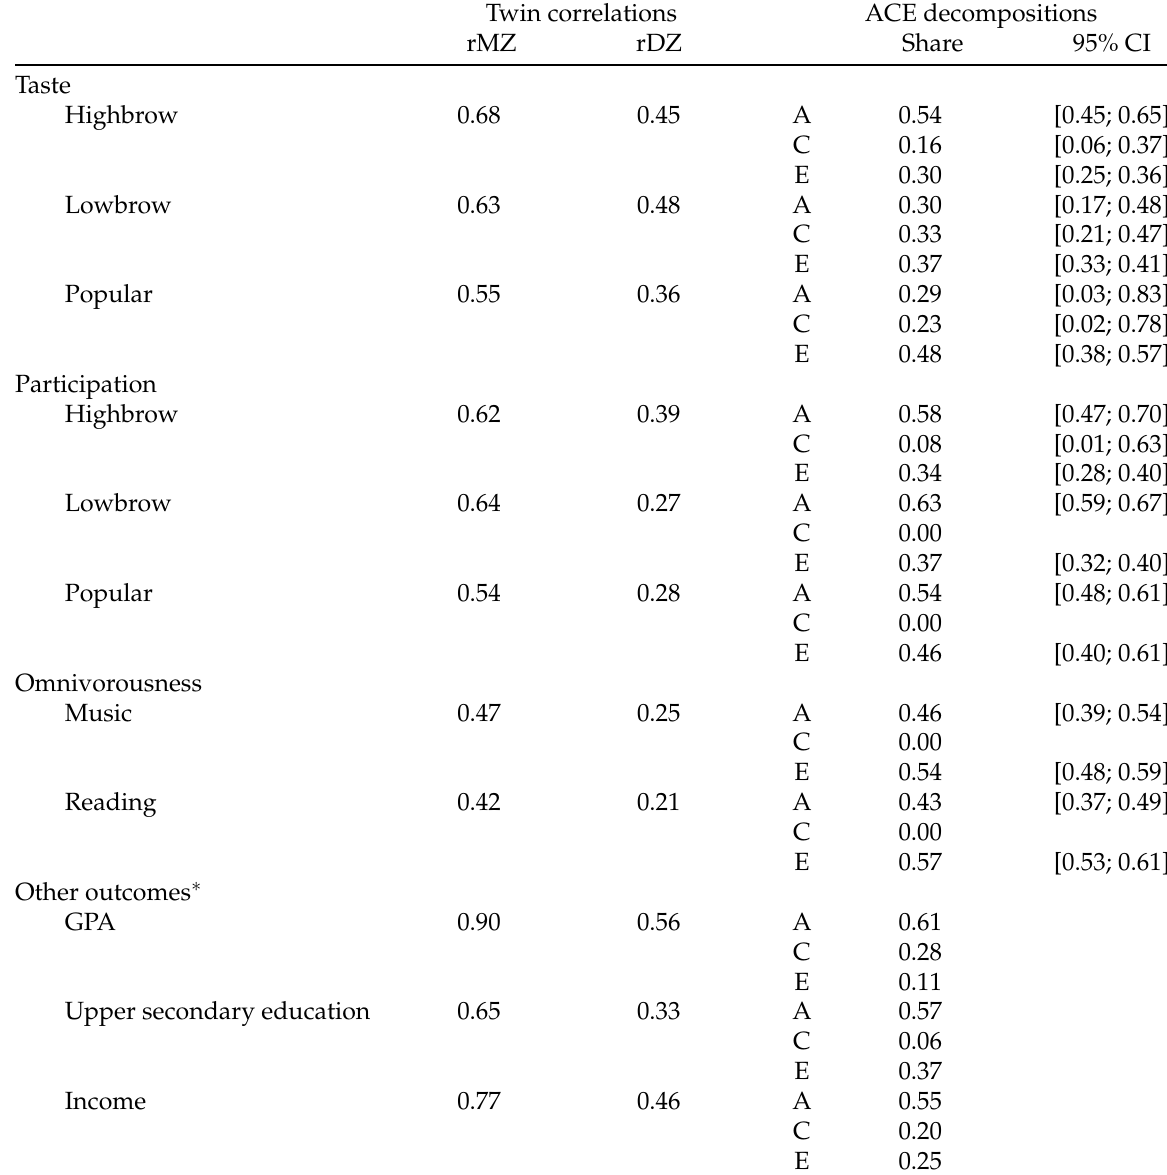
Table 3: Twin correlations and ACE decompositions of cultural taste, participation, and omnivorousness (with 95 percent confidence